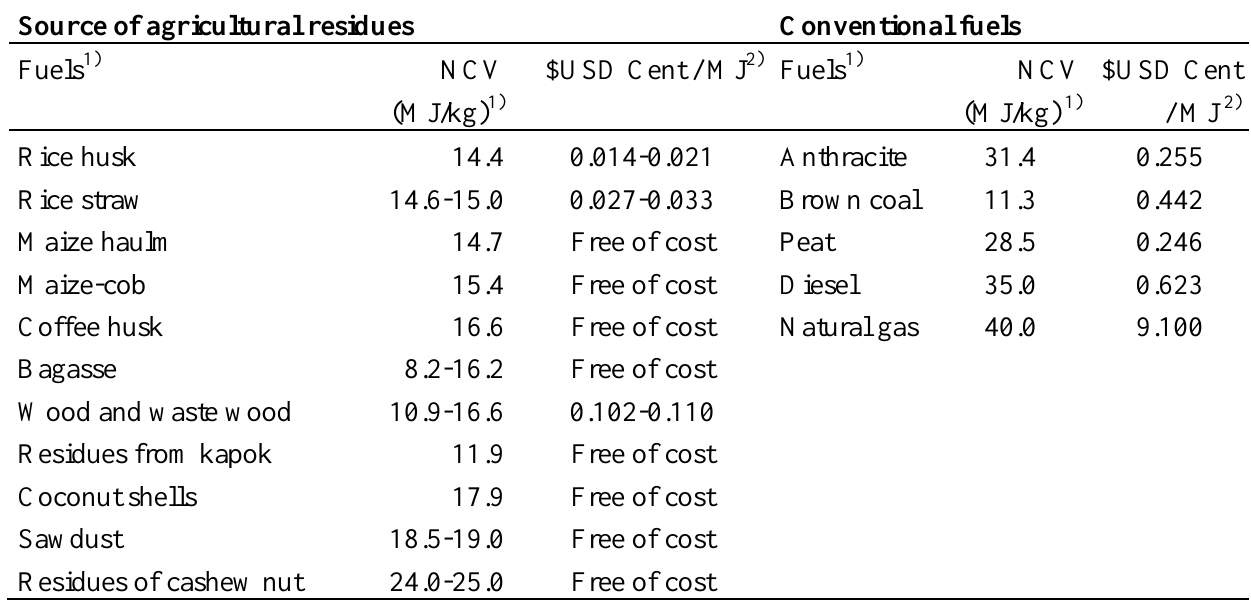
Table 2. Economic comparison of agricultural biomass residues and conventional fuels